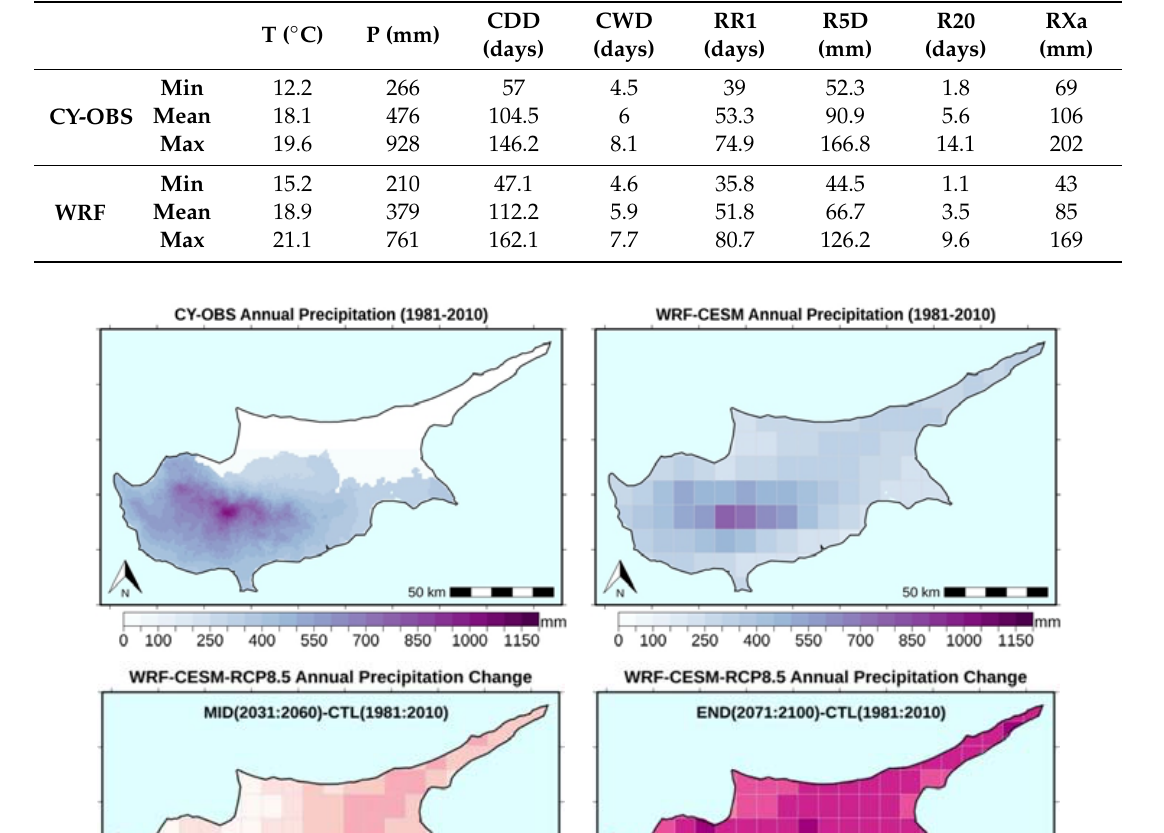
Table 2. Observed (CY-OBS) and modeled Weather Research and Forecasting (WRF) values of mean annual temperature (T), precipitation (P), consecutive dry days (CDD), consecutive wet days (CWD), number of rainy days (RR1), maximum 5-day precipitation (R5D), number of days with precipitation greater than 20 mm (R20), and absolute maximum daily rainfall (RXa) for the historical reference period (1981 to 2010). The values represent means and ranges across the 51 12 km grid points, with the CY-OBS grid points interpolated to the model’s grid.